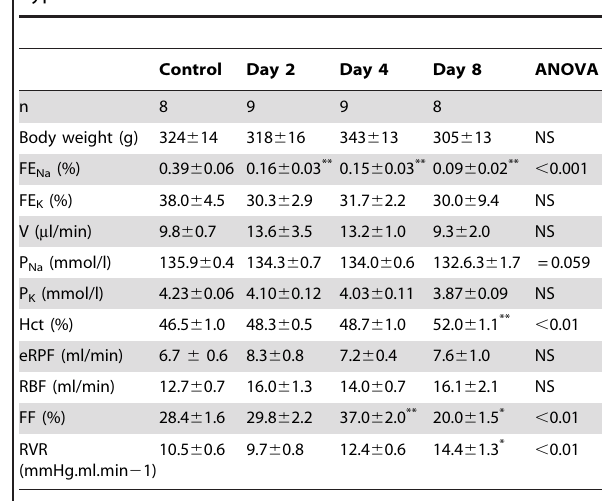
Table 1. Renal data and plasma electrolytes in cyp1a1 - Ren2 transgenic rats before and after the induction of hypertension.